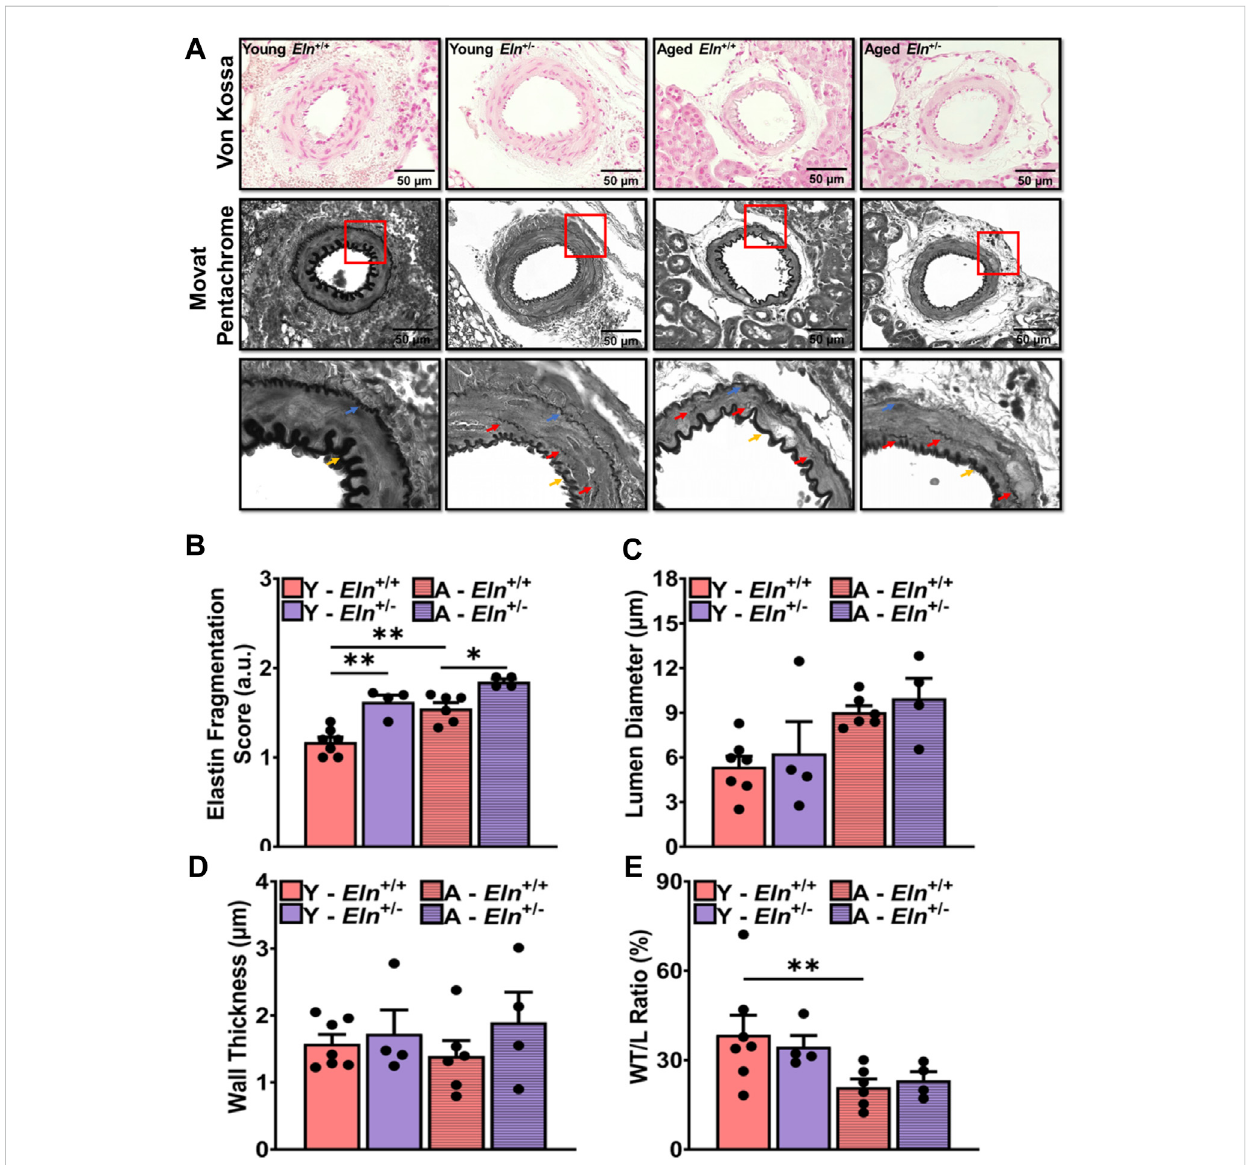
FIGURE 2 Morphological characteristics of small arteries in the renal vascular bed of young and aged Eln +/+ and Eln +/ − female mice. (A) Representative images of small intra-renal arteries with Von Kossa (top panel) and Movat Pentachrome (middle panel) staining. Movat Pentachrome images were converted to grayscale to highlight internal and external elastic laminae and fragmented elastin fi bers in the medial layer. Images were acquired in bright fi eld at ×100 magni fi cation using an All-in-one BZ-×800 microscope. Images in the bottom panel are the zoomed-in regions of interest highlighted by theredboxesinthemiddlepanel.Thezoomed-inimageshighlightthedistributionoffragmentedelastininthemediallayerofsmallintra-renalarteriesas well as changes in the internal and external elastic laminae. Blue arrows point to the external elastic lamina; yellow arrows point to the internal elastic lamina; andred arrows pointto fragmented elastin fi bersinthemedial layer. VonKossastaining ofintact vessels inthekidney exhibitednocalci fi cationin any group. Movat staining highlights increased elastin fragmentation in the medial layer and thinner elastic laminae in young Eln +/ − and aged mice. (B) Scores for elastin fragmentation in the medial layer were higher in young Eln +/ − and aged mice. From the histology images, lumen diameter (C) , wall thickness, (D) and wall-to-lumen ratio (E) were quanti fi ed. Analysis of the histological images was performed with FIJI software. Scoring of elastin fragmentation was performed by individuals who were blinded to the age and genotype of the mice. N = 3 – 7 vessels per animal from 4 – 6 animals per group. All values in the bar graphs are mean ± sem. * p < 0.05; *** p < 0.001. Y, young; A,